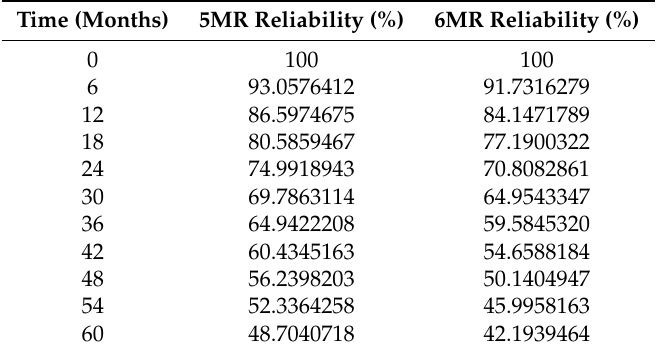
Table 1. 5MR and 6MR reliability ( λ s = 3 λ d ).